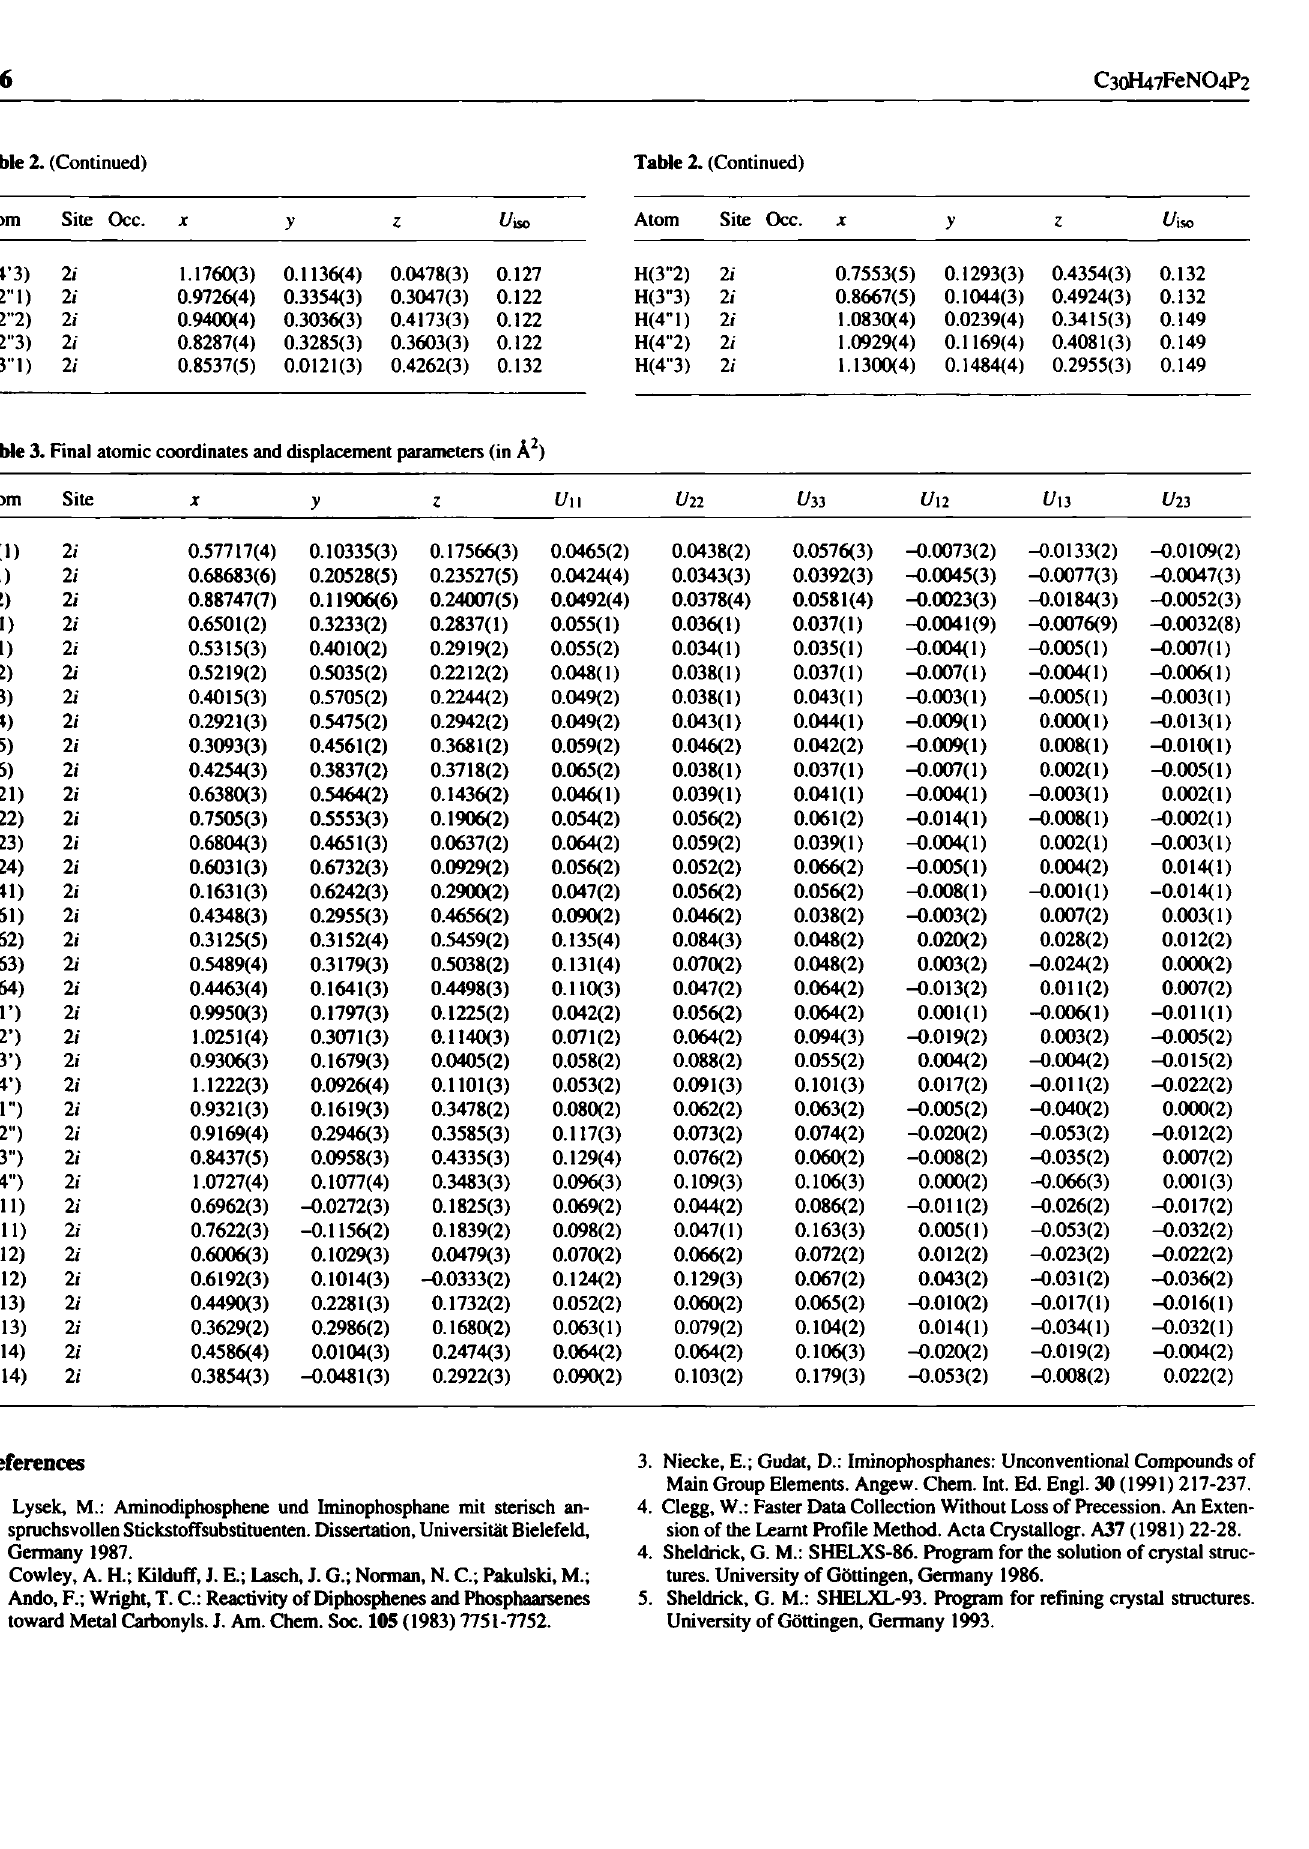
Table 3. Final atomic coordinates and displacement parameters (in À 2